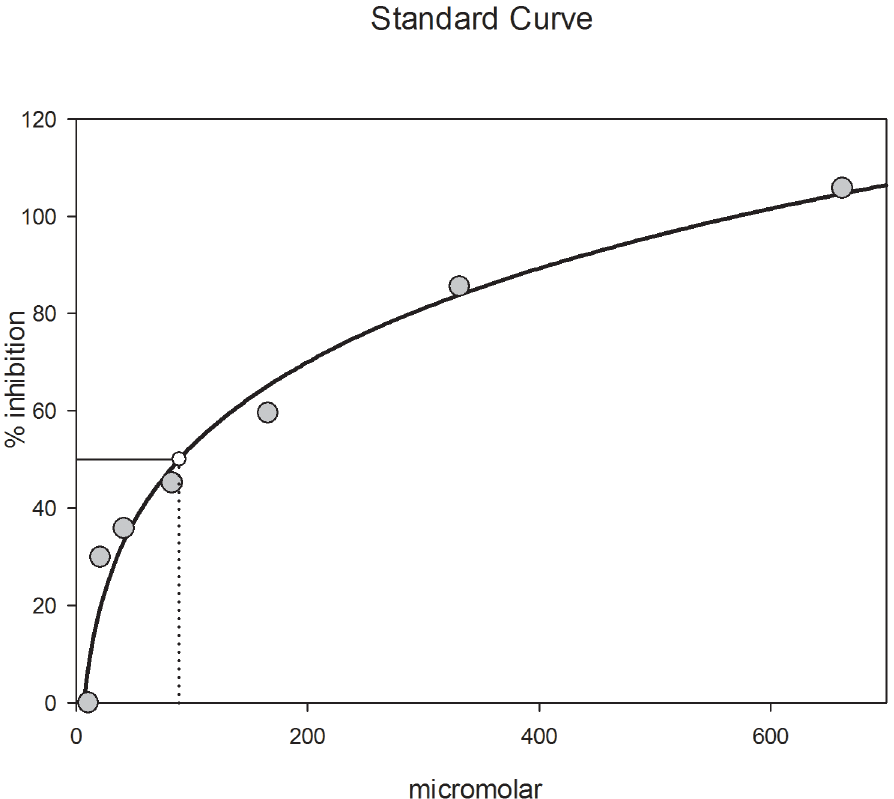
Fig 2. Dose-dependent inhibition of the fluorescent AGE formation by Onco A, via spectrofluorimetric method. r 2 0.97.